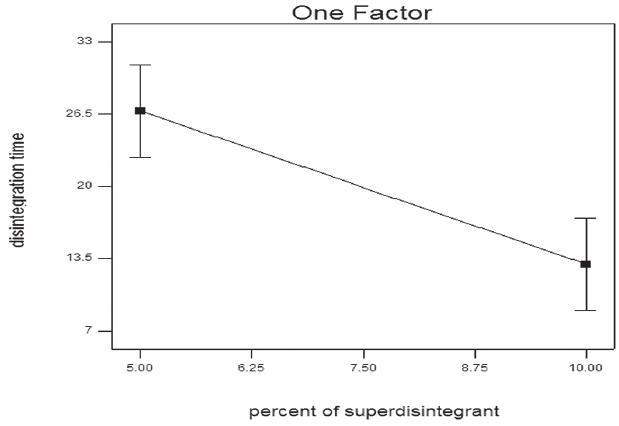
FIGURE 3 - Effect of percent of superdisintegrant on the disintegration time of MLX